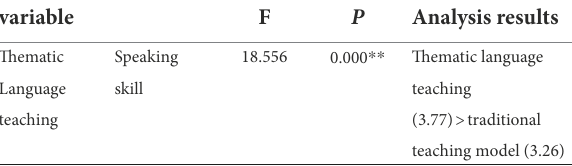
TABLE 2 Difference analysis of thematic language teaching and speaking skill.